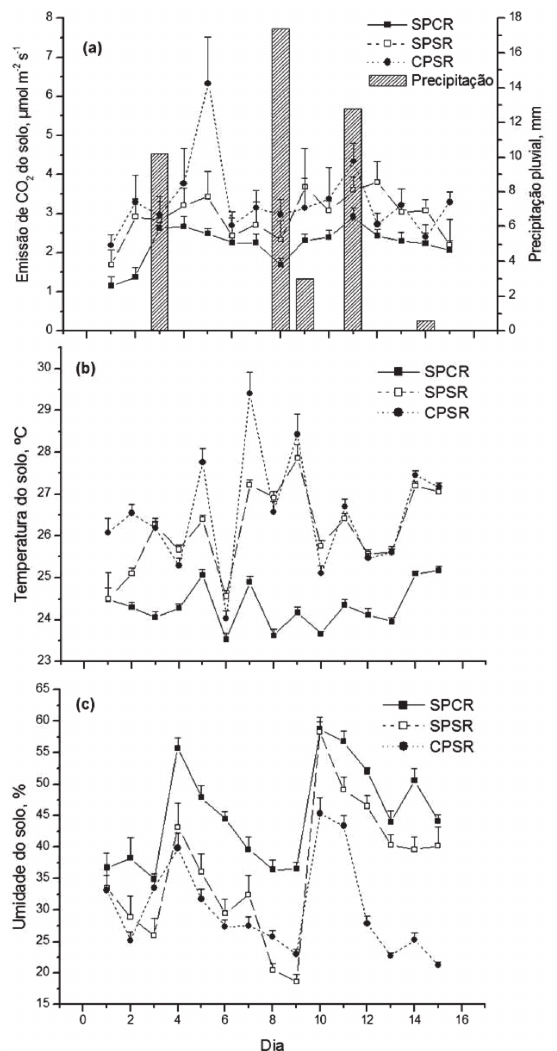
Figura 1. Emissão de CO 2 do solo e precipitações pluviais ocorridas no período de estudo (a), temperatura do solo (b) e umidade do solo (c) com metade das barras de erro-padrão nos diferentes manejos: sem preparo do solo e com resíduo (SPCR), sem preparo e sem resíduo (SPSR) e com preparo e sem resíduo